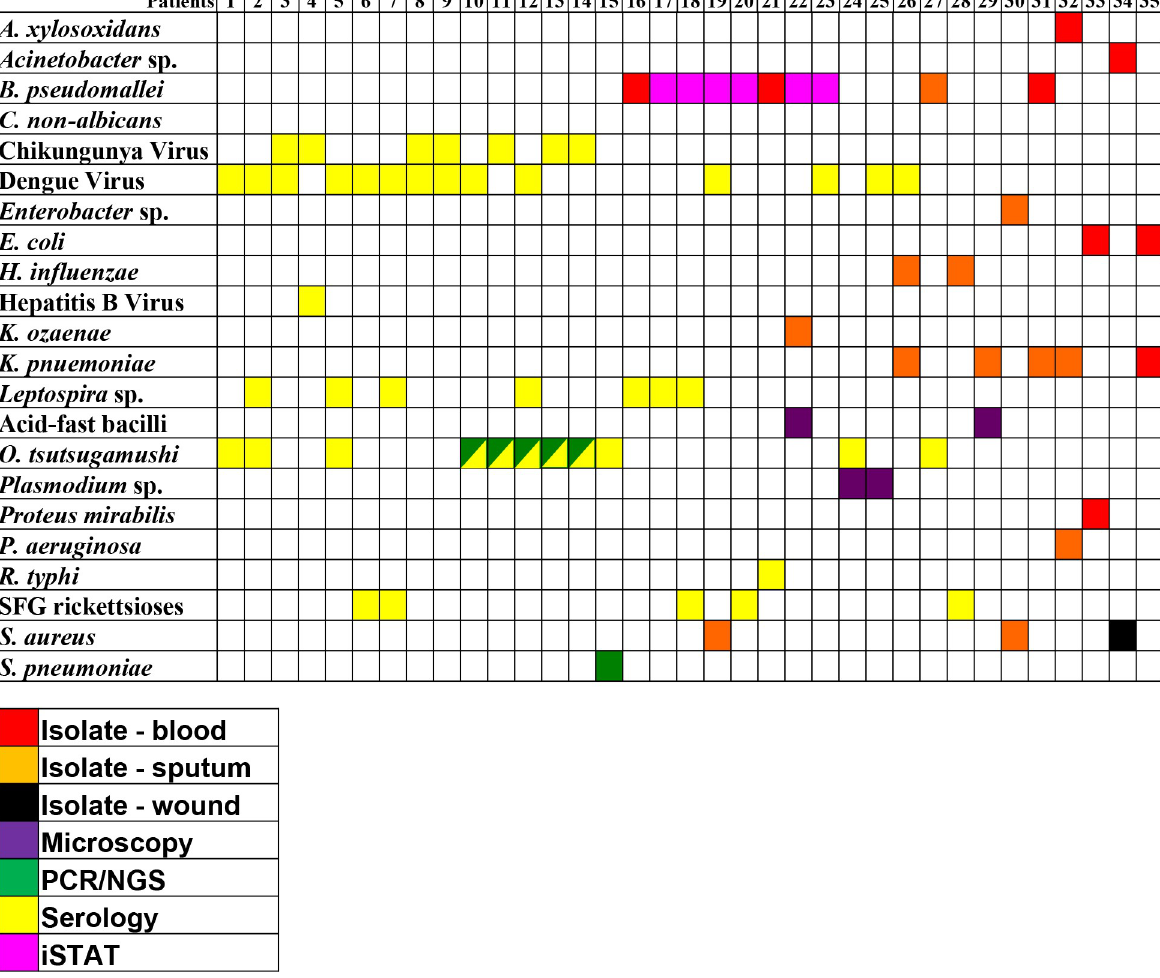
Fig 2. Coinfections identified in 200 patients. Potential co-infections indicated in 35 out of 200 patients. Each column, numbered 1–35 indicate the results from an individual patient. Colored boxes indicate a positive result from each patient for the pathogen listed in the first column, and the color of the box in the key below indicates the methodology used to detect evidence of that